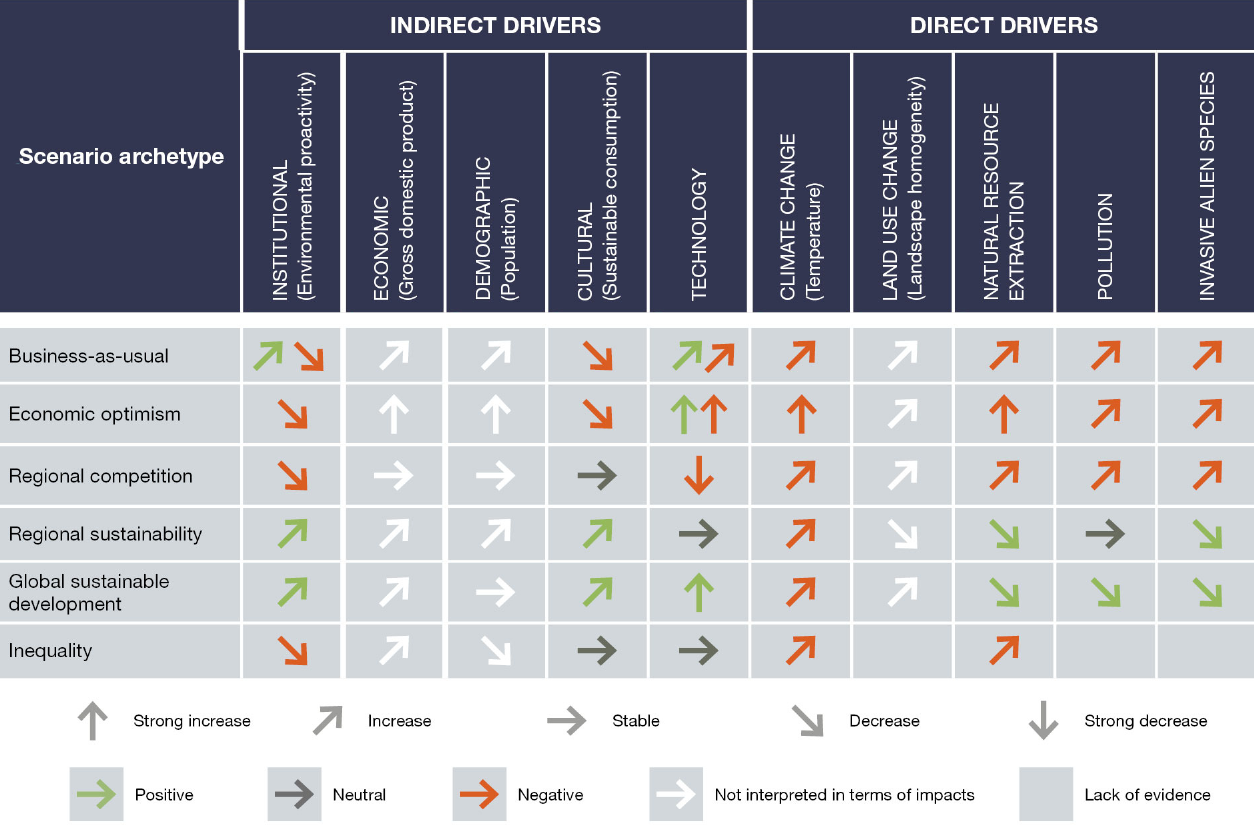
Fig. 1 . Trends in indirect and direct drivers in the six scenario archetypes for Europe and Central Asia. Arrows in the table represent the expert interpretation of the magnitude of trends in drivers across all reviewed scenarios found within the archetypes. Color coding represents the expert interpretation of the impact of the trend on nature and nature’s contributions to people. Source: IPBES (2018).